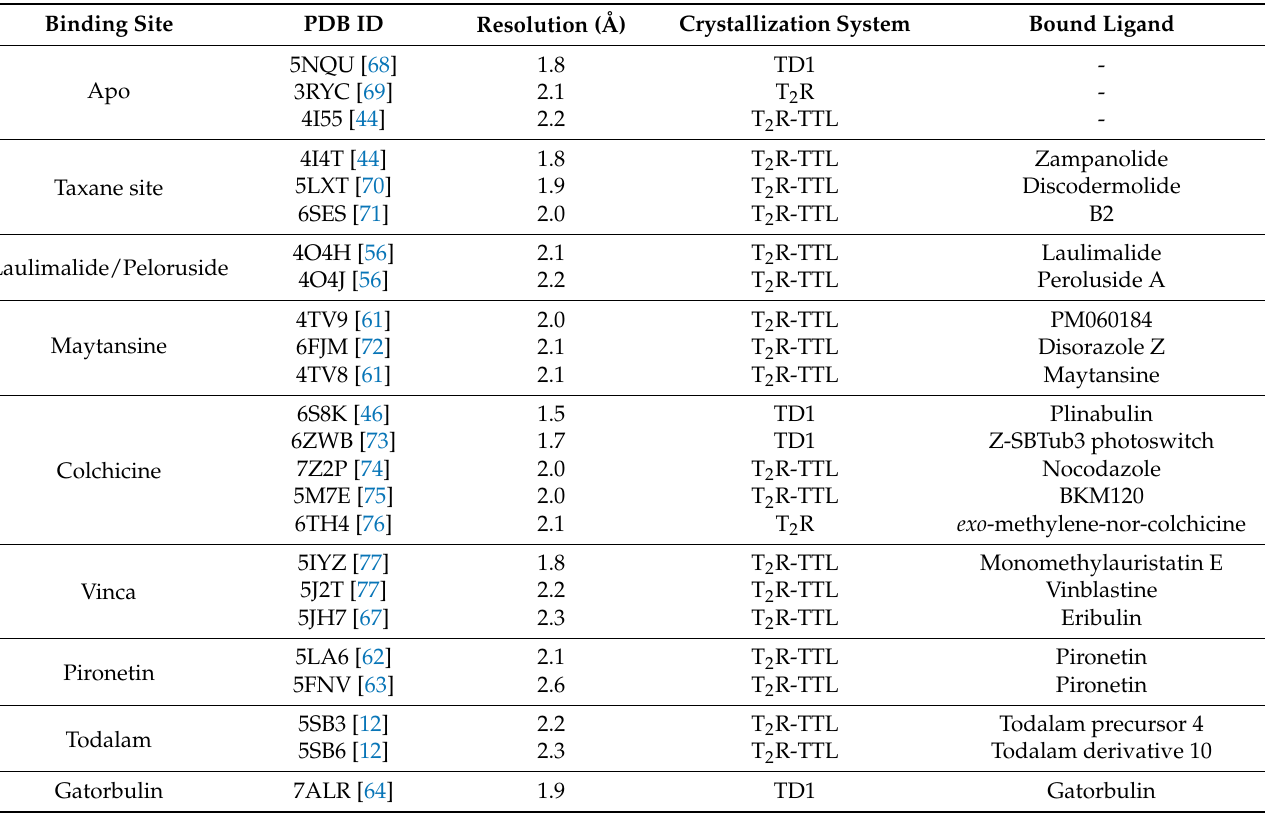
Table 1. List of high-resolution tubulin crystal structures by binding site.